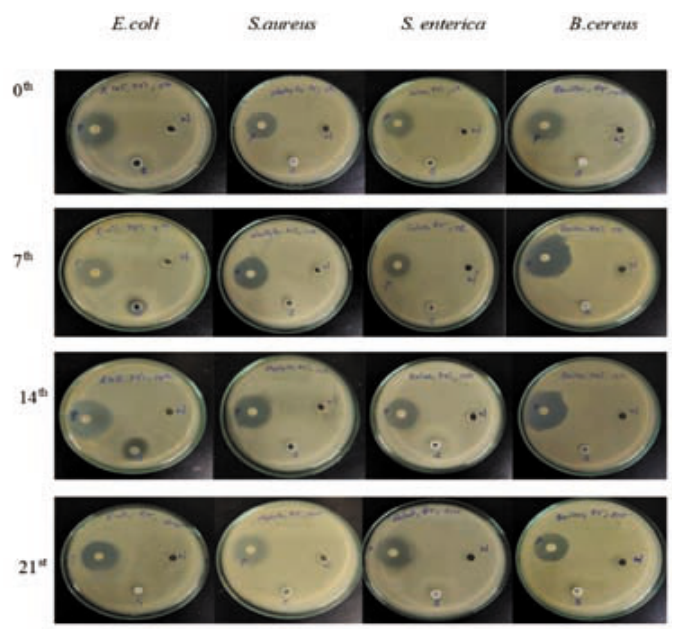
Fig. 3. Antibacterial activity of the WSPE of fermented milk made from goat milk heated to 85°c/10min against different pathogens during cold storage (inhibition zone in mm). P-positive control, N-negative control, S-sample